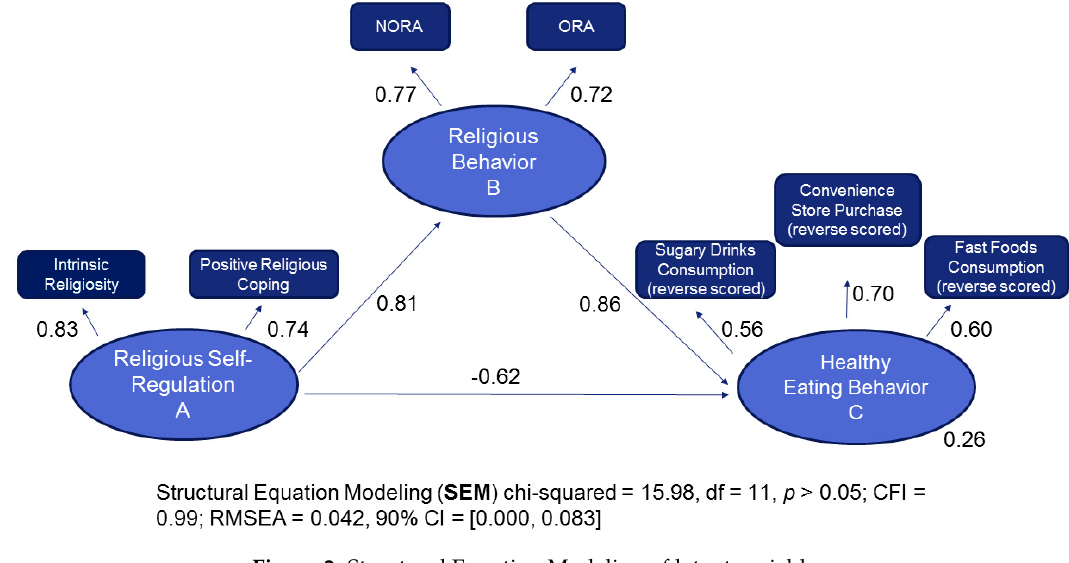
Figure 2. Structural Equation Modeling of latent variables.